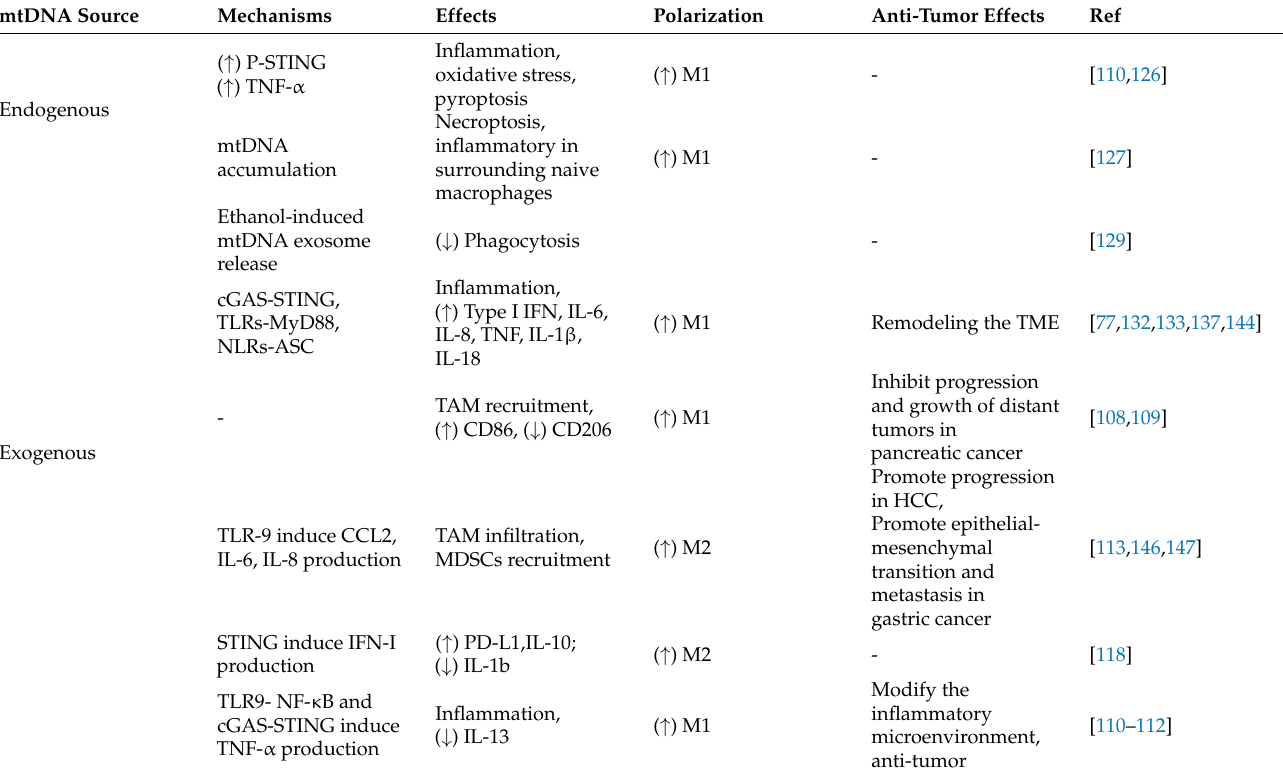
Table 3. The effects of mtDNA on